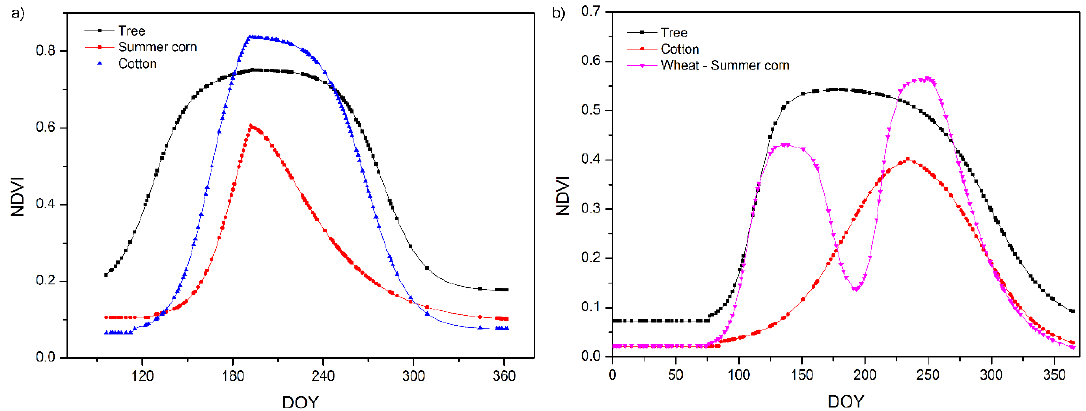
Figure 6. Simulated phenology for all land cover types in ( a ) Bole and ( b ) Luntai.